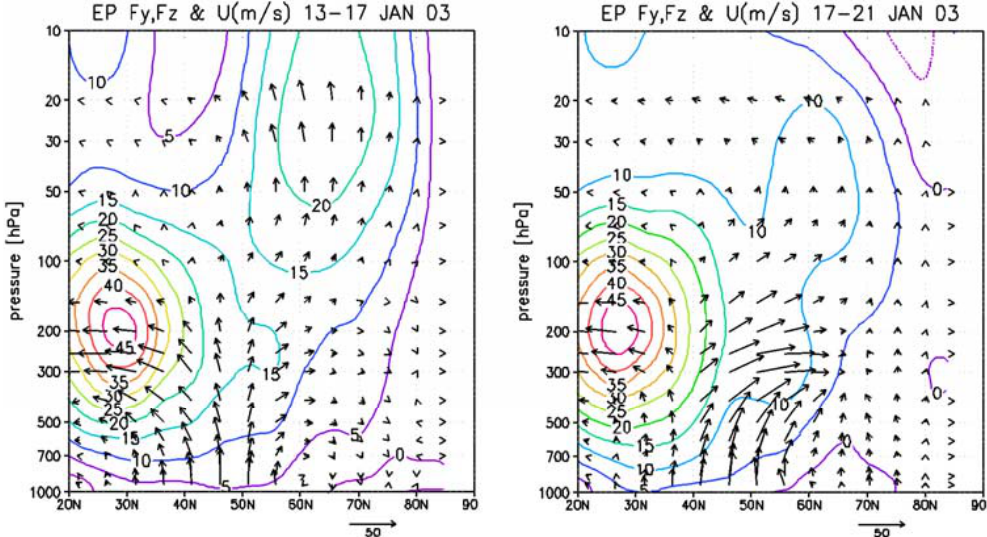
Fig. 12. Height-latitude cross section of E-P flux (m 2 s − 2 ) and zonal mean zonal wind (ms − 1 ) averaged from 13–17 January (left panel) and 17–21 January (right panel) of 2003. The vertical component of EP-flux is multiplied by a factor of 100.